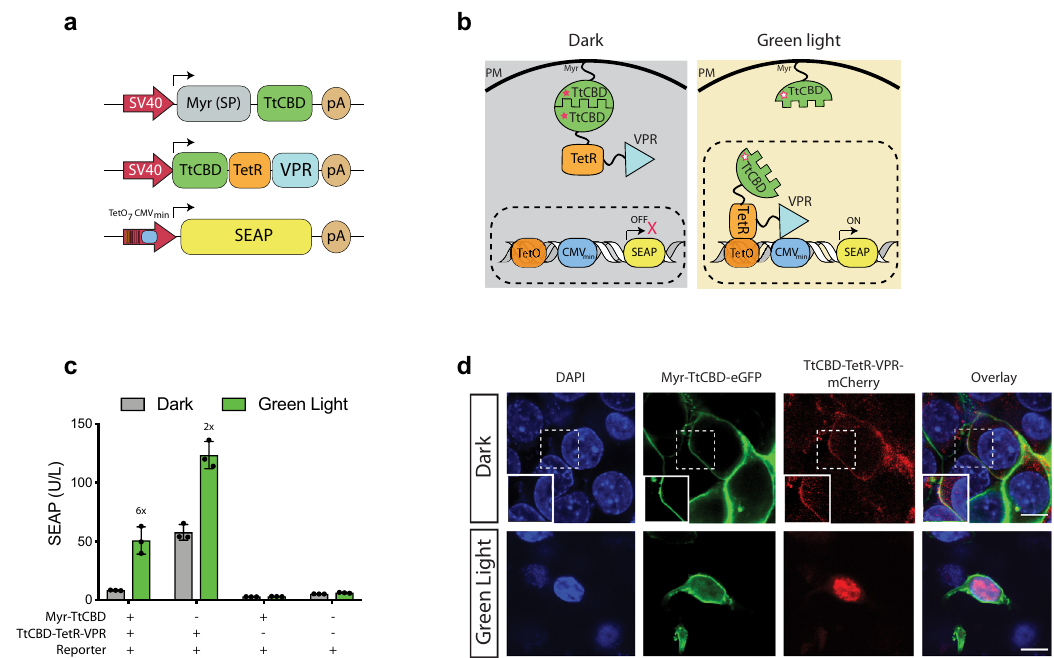
Fig. 1 Design of the green-light-operated smart-watch control system (Glow Control) for mammalian cells. a The DNA constructs used for the Glow Control system. The Glow Control circuit is based on dissociation of a Myristoylation signal peptide-TtCBD (pMMZ269; P SV40 -Myr-TtCBD-pA) and TtCBD-TetR-VPR transactivator (pMMZ273; P SV40 -TtCBD-TetR-VPR-pA), leading to expression of the SEAP reporter gene from the synthetic promoter P TET (pTS1017; P TetO7- P CMVmin -SEAP-pA). b Schematic representation of Glow Control in the dark and upon illumination with green light. In the presence of AdoB 12 ( fi lled asterisk) and in the dark, TtCBD-TetR-VPR is bound to plasma-membrane-anchored Myristoylation signal peptide-TtCBD. Green light causes dissociation of the TtCBD-transactivator from the plasma membrane, which enables its translocation into the nucleus and subsequent activation of reporter gene (SEAP) expression. c Dependency of the Glow Control system on the presence ( + ) or absence ( − ) of each component was studied by quanti fi cation of SEAP in the supernatant of HEK293T cells transfected with the indicated plasmids. Cells were induced with pulsed green light (545 nm; 15 s ON/45 s OFF and 88 μ W/cm 2 ) for 48 h. Plots represent mean ± SD of n = 3 biologically independent samples. Numbers above the bars indicate fold changes of reporter (SEAP) vs. the corresponding dark group. d Microscopic images of HEK293T cells co-transfected with pMMZ351 (P SV40 -Myr-TtCBD-GFP-pA), pMMZ429 (P SV40 -TtCBD-TetR-VPR-mCherry-pA), and P TET (pTS1017; P TetO7- P CMVmin -SEAP-pA) in the dark and after pulsed green-light illumination (545 nm; 15 s ON and 45 s OFF and 88 μ W/cm 2 ) for 48 h. Cells were fi xed and stained with DAPI. Scale bars are 10 μ m. A representative image of three replicates from each group is shown. Source data are provided as a Source Data fi